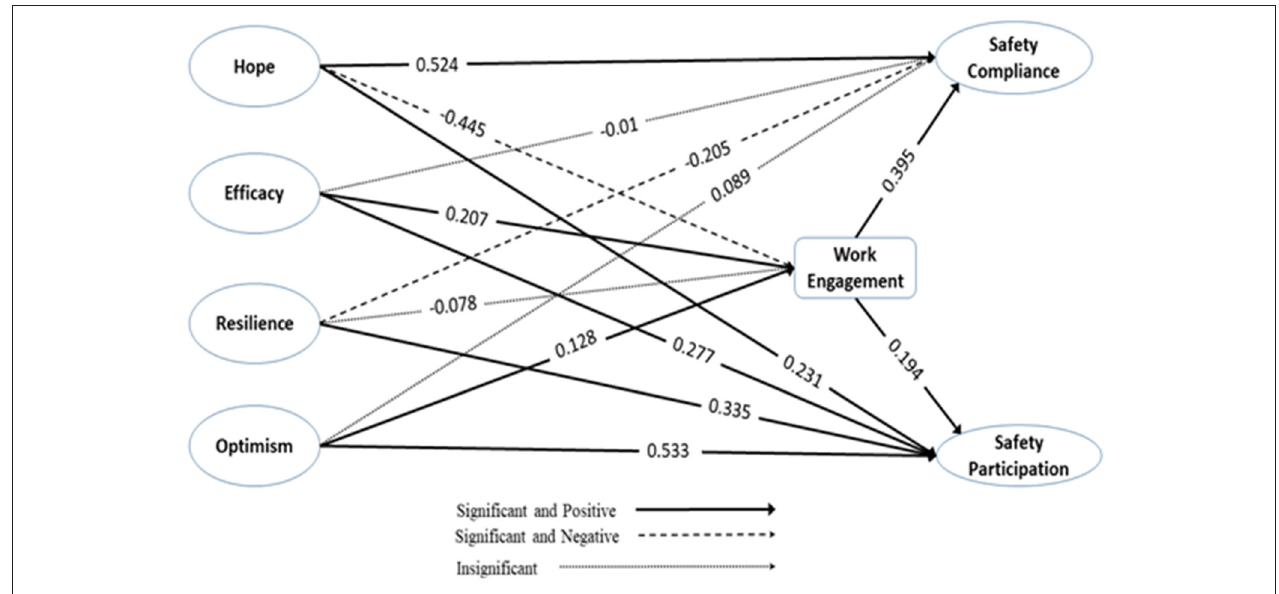
FIGURE 2 | The final structural model and impact paths.